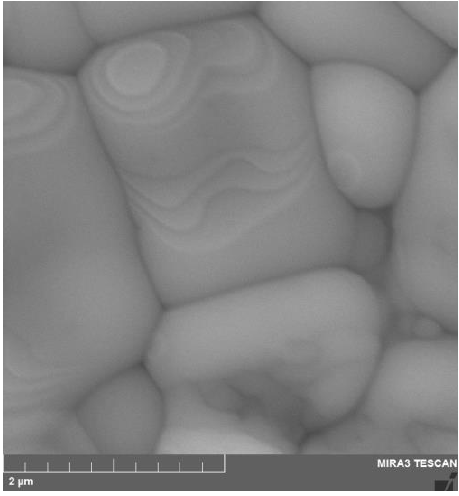
Figure 4. SEM image of the surface of sintered YSZ sample.